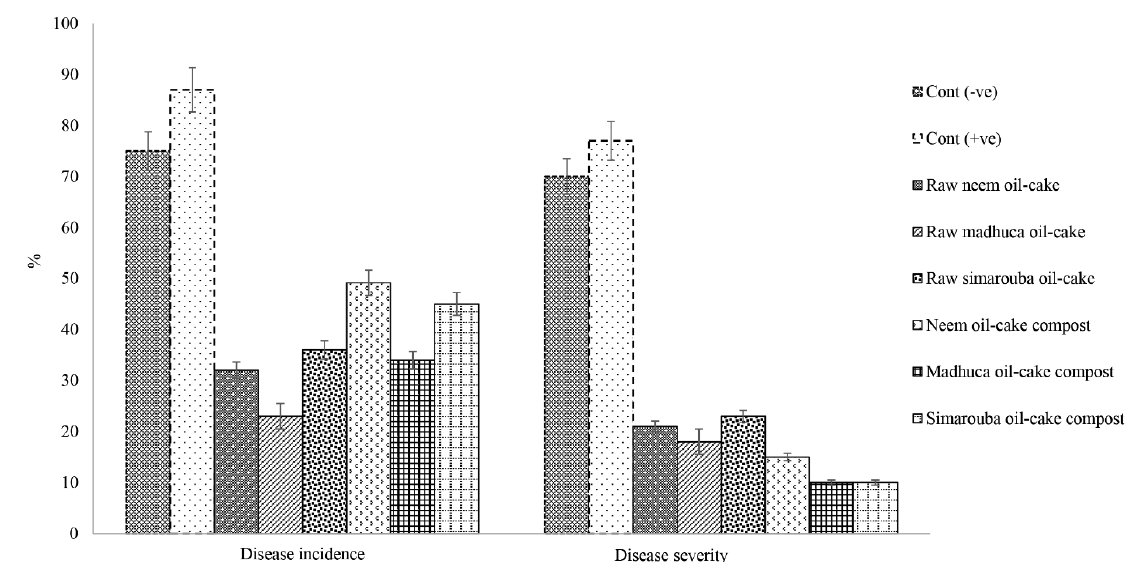
Fig. 2 The incidence (%) and severity (%) of leaf spot disease caused by Alternaria tenuissima in chilli grown in potting medium amended with raw or composted oil-cakes of neem, madhuca and simarouba